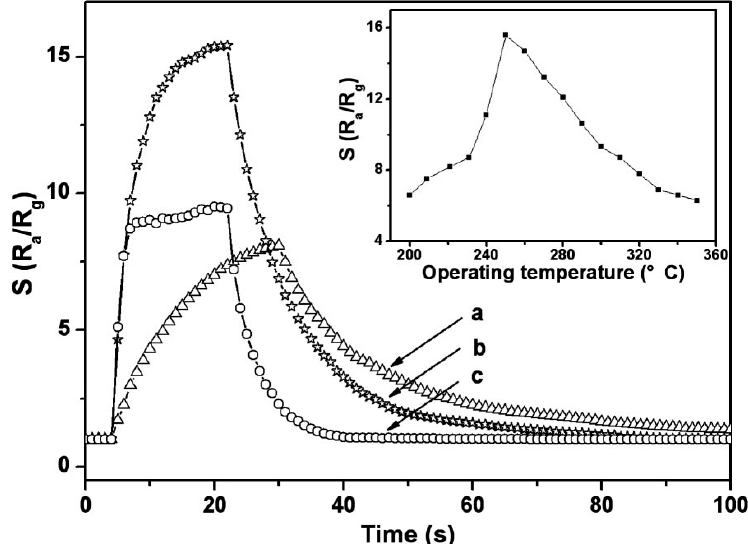
Figure 8. Response of the present ZnO to 10 ppm ethanol at various operating temperatures of ( a ) 220; ( b ) 250; and ( c ) 300 °C. The inset shows the sensitivity to 10 ppm ethanol at operating temperatures in the range of 200–350 °C. Adapted figure from [83] with permission from copyright (2009), American Chemical Society (Washington, DC, USA).